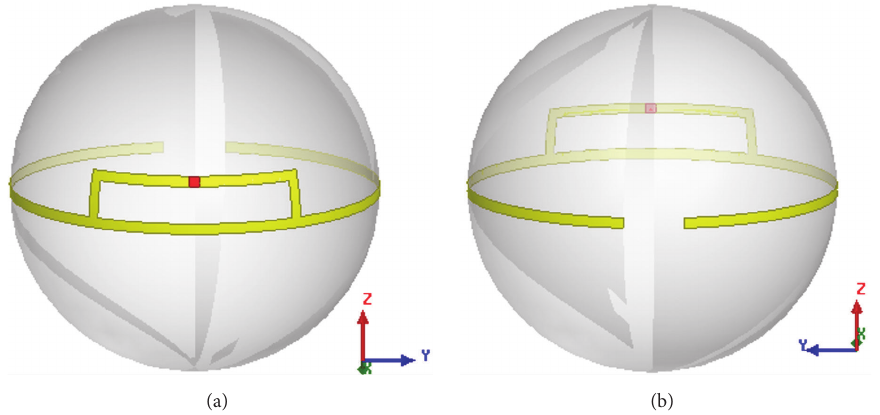
Figure 6: Structure of the 3D spherical antenna with T-match: (a) front view and (b) back view.